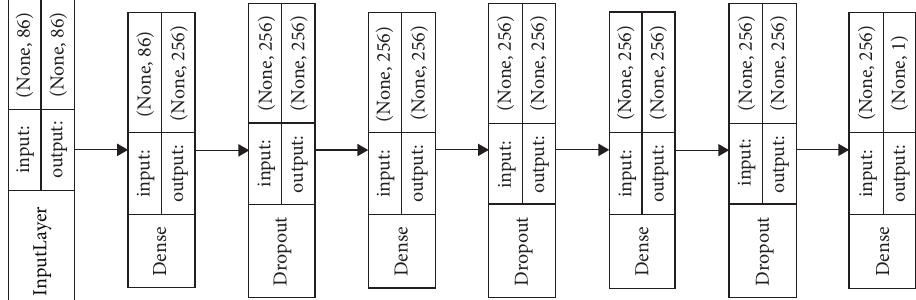
Figure 1: A fully connected (dense) ANN was employed to estimate traffic volumes.